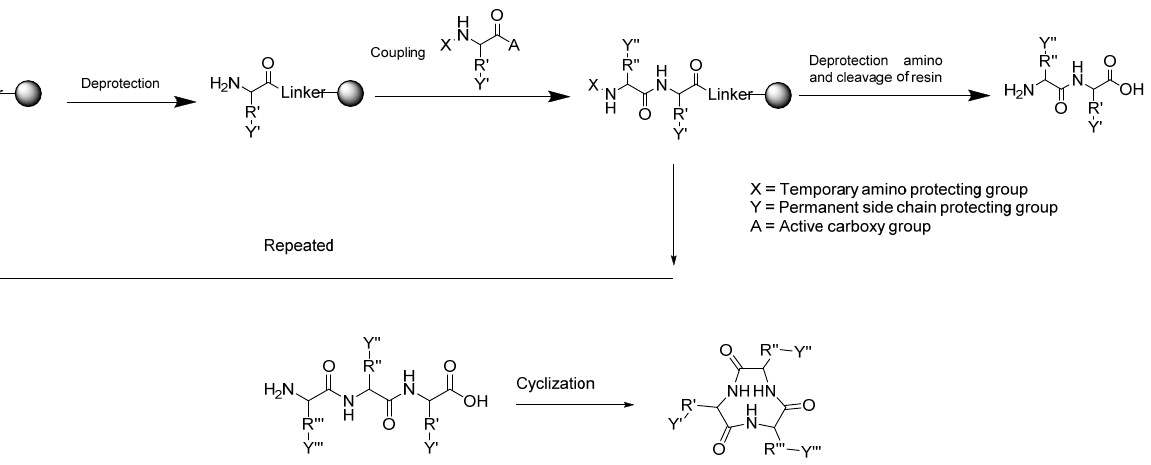
Figure 3. Synthesis of cyclic peptides through a combination of solid phase and liquid phase peptide synthesis strategies.